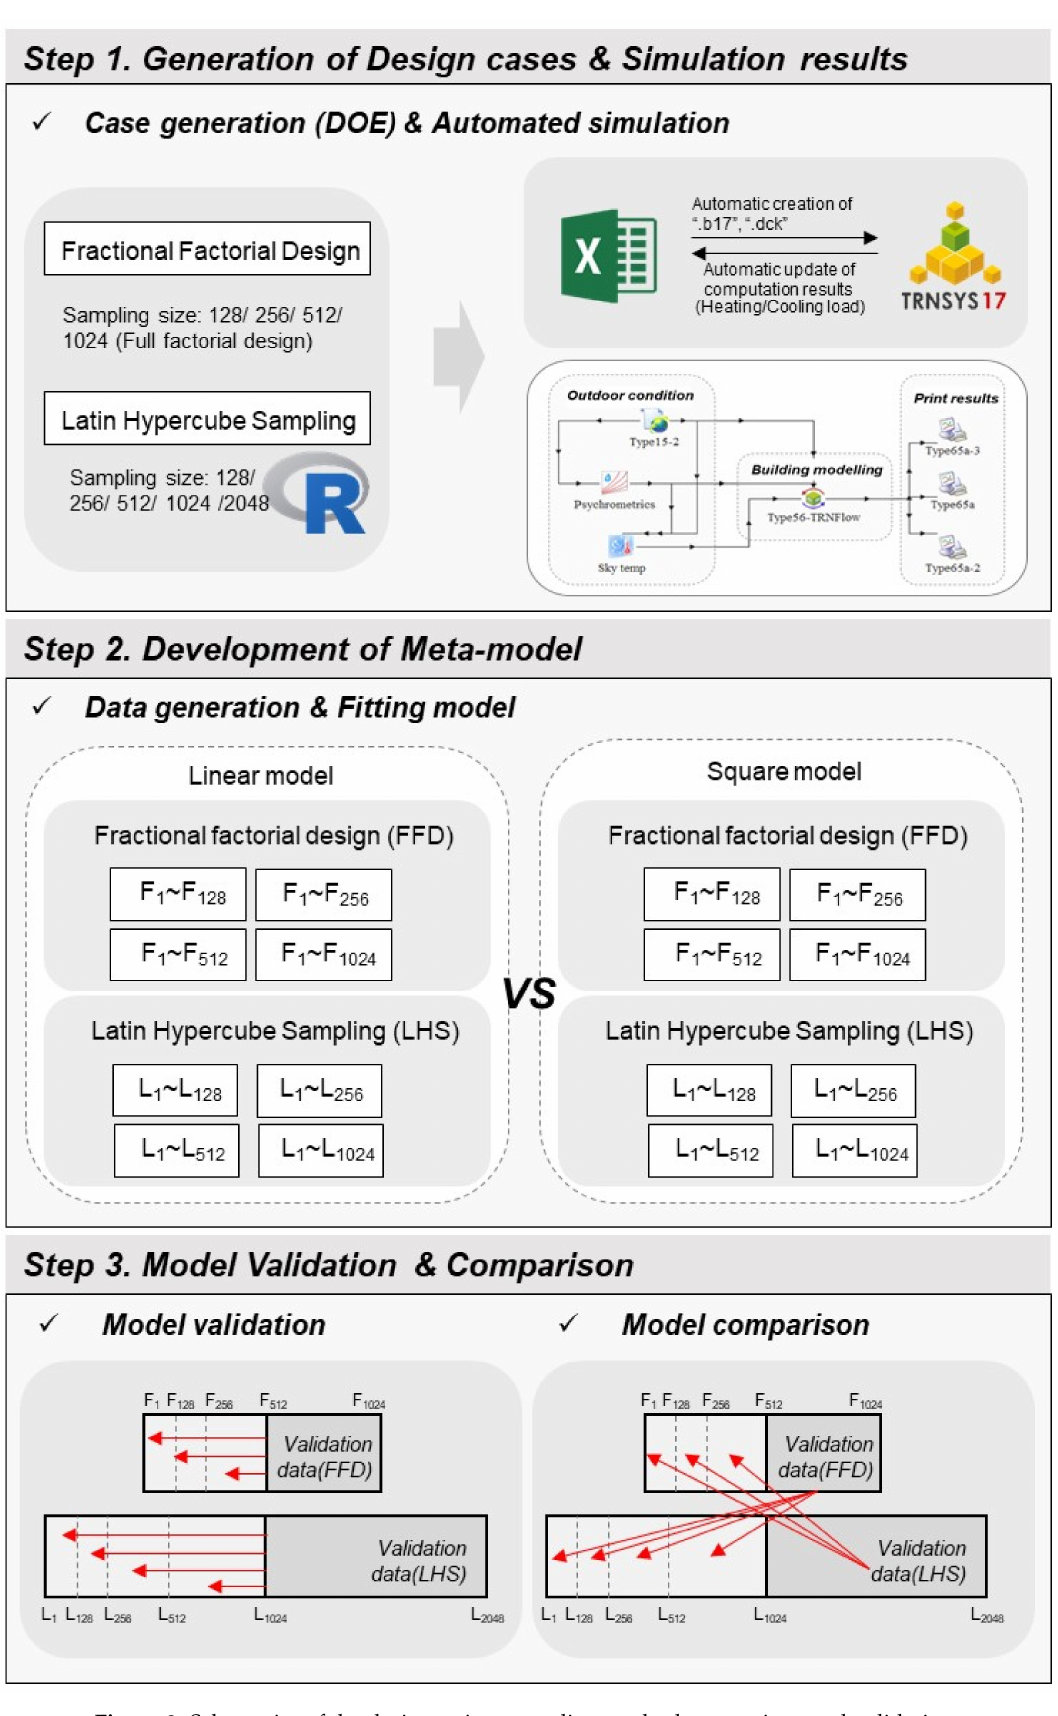
Figure 3. Schematics of the design points sampling method comparison and